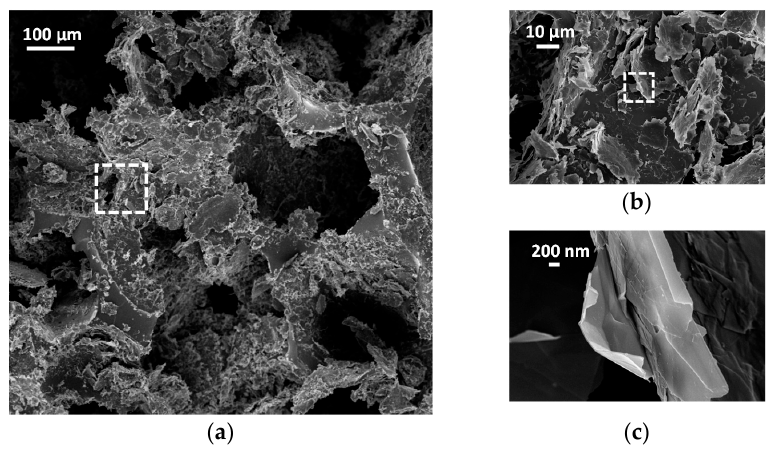
Figure 6. AFM images of a MLG flake and corresponding height profiles, before ( a , b ) and after ( c , d ) solvent evaporation and re-dispersion.